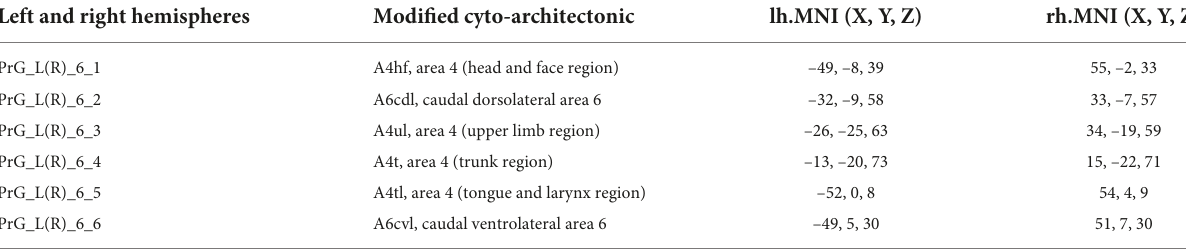
TABLE 2 Primary motor cortex subregions within the Brainnetome atlas. Left and right